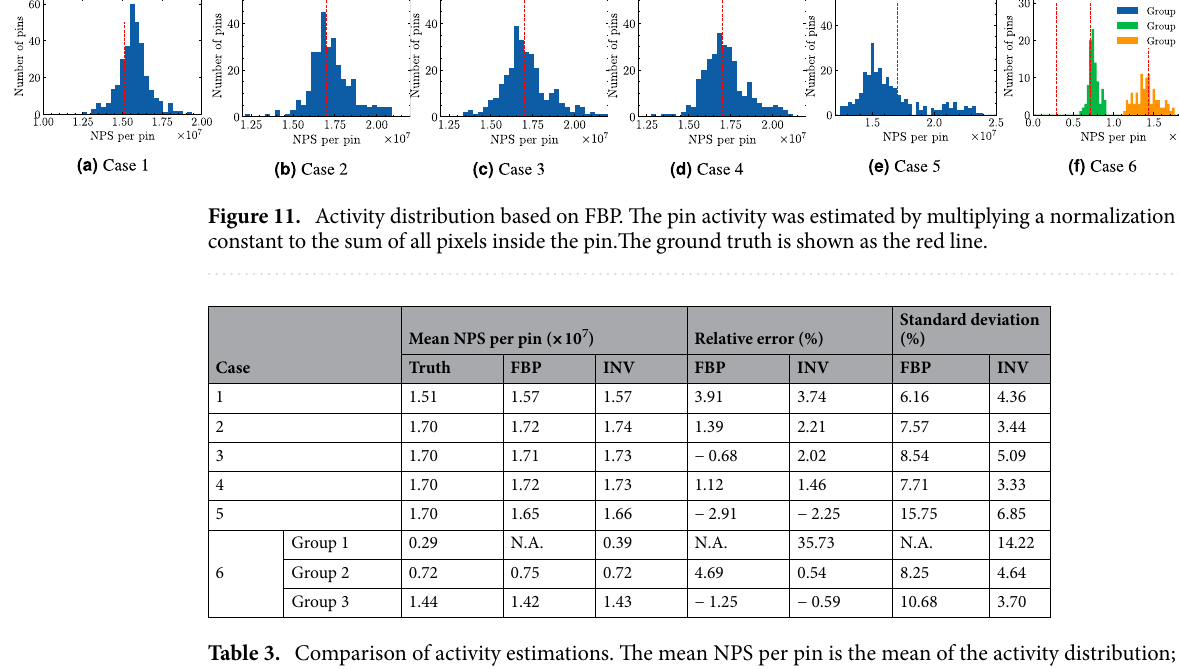
Table 3. Comparison of activity estimations. The mean NPS per pin is the mean of the activity distribution; relative error is the relative difference between the mean activity and ground truth; standard deviation refers to the standard deviation of the pin activity distribution. For FBP in Group 1 of Case 6, no data is shown because no present pin is identified.